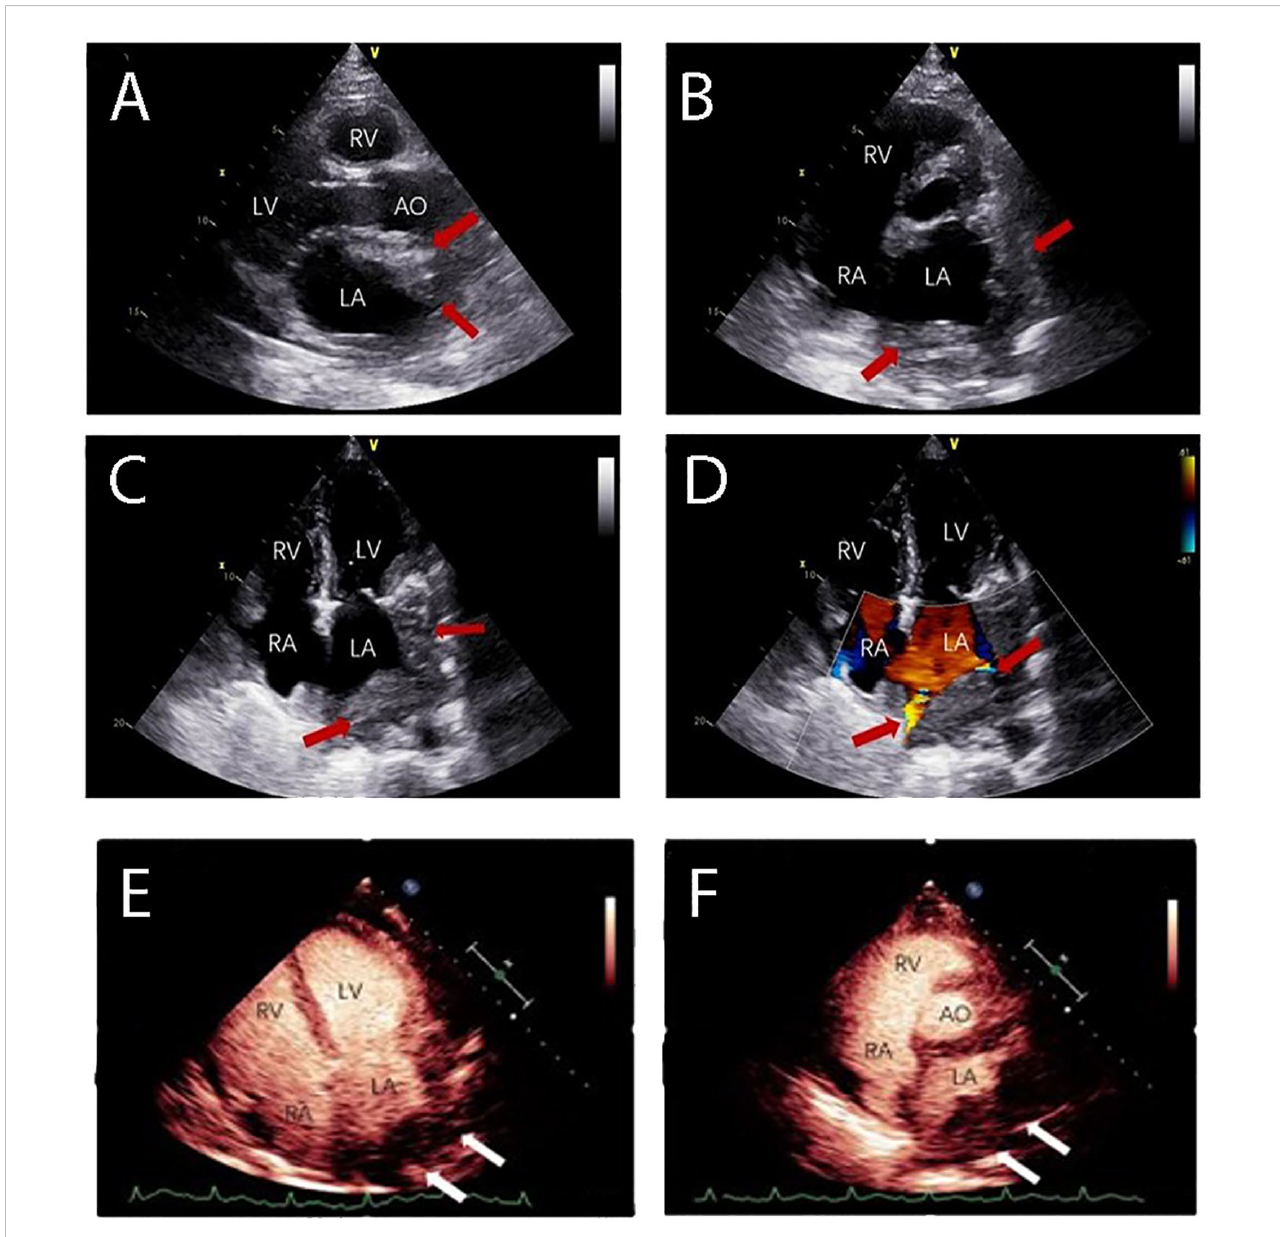
FIGURE 2 The patient experienced dyspnea and had a refractory bilateral pleural effusion after receiving multi-line chemotherapy. Transthoracic echocardiography showed the heart in fi ltrated by lymphoma. (A) Long axis section of left ventricle showing a slight hypoechoic mass in the anterior wall of the left atrium. (B) Lateral wall of left atrium and left atrial appendage were in fi ltrated. (C, D) Four-chamber view showed pulmonary vein in fi ltration. Cardiac ventricular opaci fi cation (CVO): (E, F) An irregular mass was present at the entrance of pulmonary veins in the left atrium with rapid irregular perfusion and complete enhancement. (LV: Left Ventricle; RA: Right Atrium; RV: Right Ventricle; LA: Left